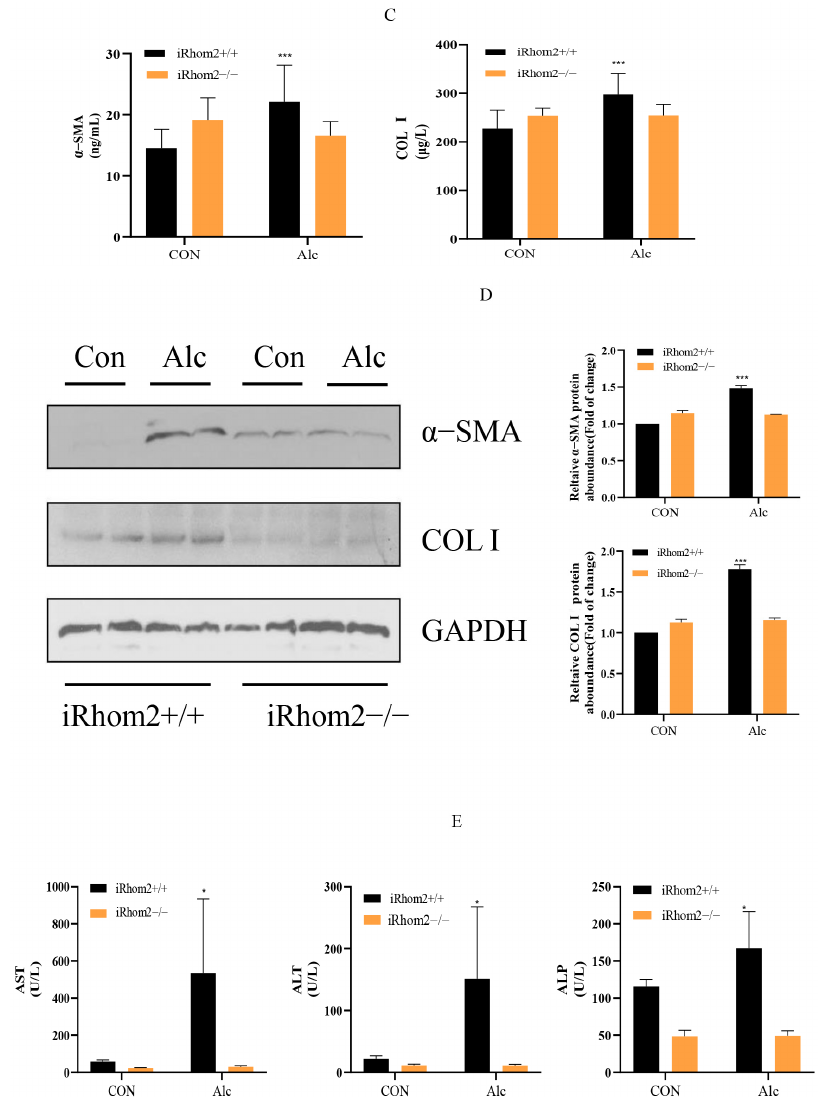
Figure 3. H and E and Masson tissue sections showing that the knockout of iRhom2 can reduce liver injury and fibrotic collagen, and the content of collagen stained by Masson was quantified ( A , B ); Elisa and WB showing that the contents of α -SMA and COL Ⅰ in normal mice exposed to alcohol for a long period increases. However, the content of fibrosis-specific proteins in the livers of iRhom2-knockout mice induced by alcohol remained unchanged ( C , D ); The ALT, AST, and ALP levels in mouse serum proved that the knockout of iRhom2 can reduce liver injury ( E ); The data are expressed as the mean value ± SD ( n = 6). * p < 0.05, and *** p < 0.001 vs. the iRhom2+/+/CON group.